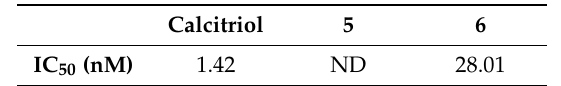
Table 1. Affinities of the compounds to recombinant vitamin D receptor a .